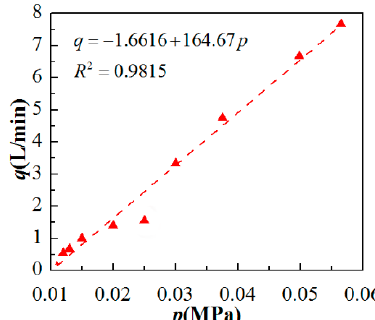
Figure 6. Suction capacity ( q ) as a function of negative pressure ( p ). Table 3. The velocity difference of liquid-air.